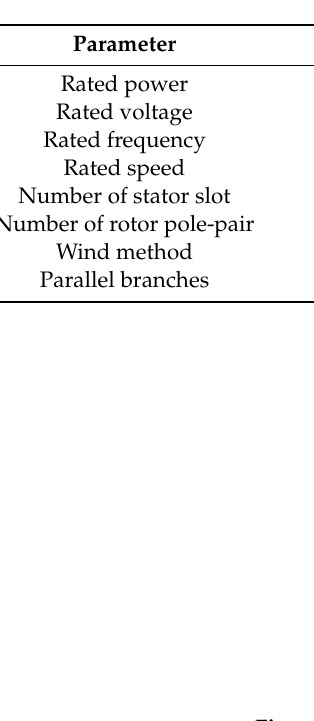
Figure 1. Calculation model of the prototype motor.